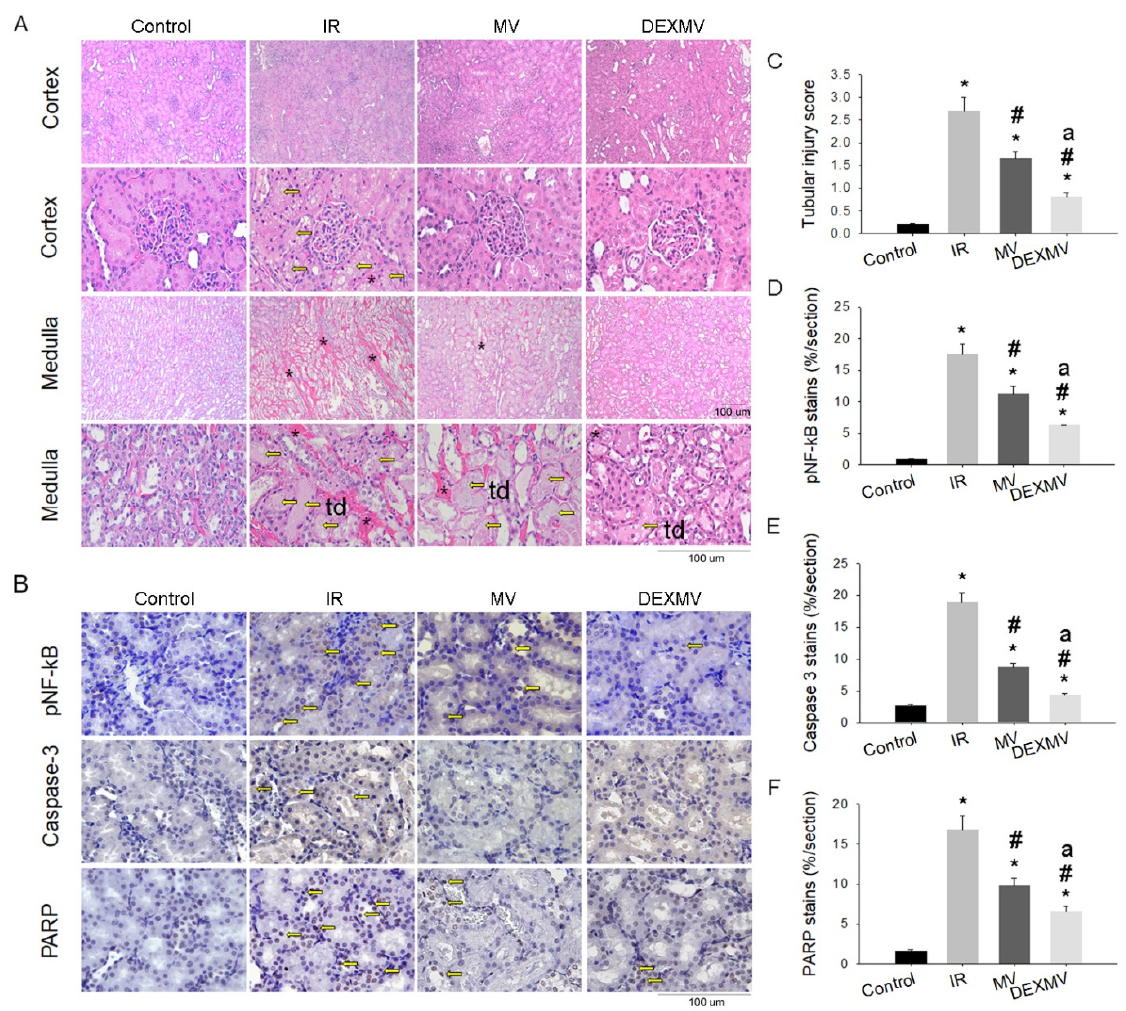
Figure 4. Effect of MVs or DEXMVs on pathologic parameters in renal cortex and medulla by H&E stain ( A ), pNF- κ B, Caspase-3, and PARP stain ( B ) in CON, IR, MV, and DEXMV groups. The statistical data of tubular injury score ( C ), p-NF- κ B expression ( D ), Caspase-3 expression, ( E ) and PARP expression ( F ) are indicated. Data are expressed as mean ± SEM in each group (n = 6) using single values. * p < 0.05 compared with CON group. td: tubular dilation. Yellow arrows in ( A ) indicate tubular dilation (td). Asterisks in ( A ) indicate erythrocyte accumulation. Yellows in ( B ) indicate each brown stain. MV, microvesicle; IR, ischemia/reperfusion; IRMV, ischemia/reperfusion with microvesicle; IRDEXMR, ischemia/reperfusion with dexmedetomidine preconditioned microvesicle; PARP, poly-(ADP-ribose)-polymerase; SEM, standard error mean. # p < 0.05 compared with IR group. a p < 0.05 vs. MV group.